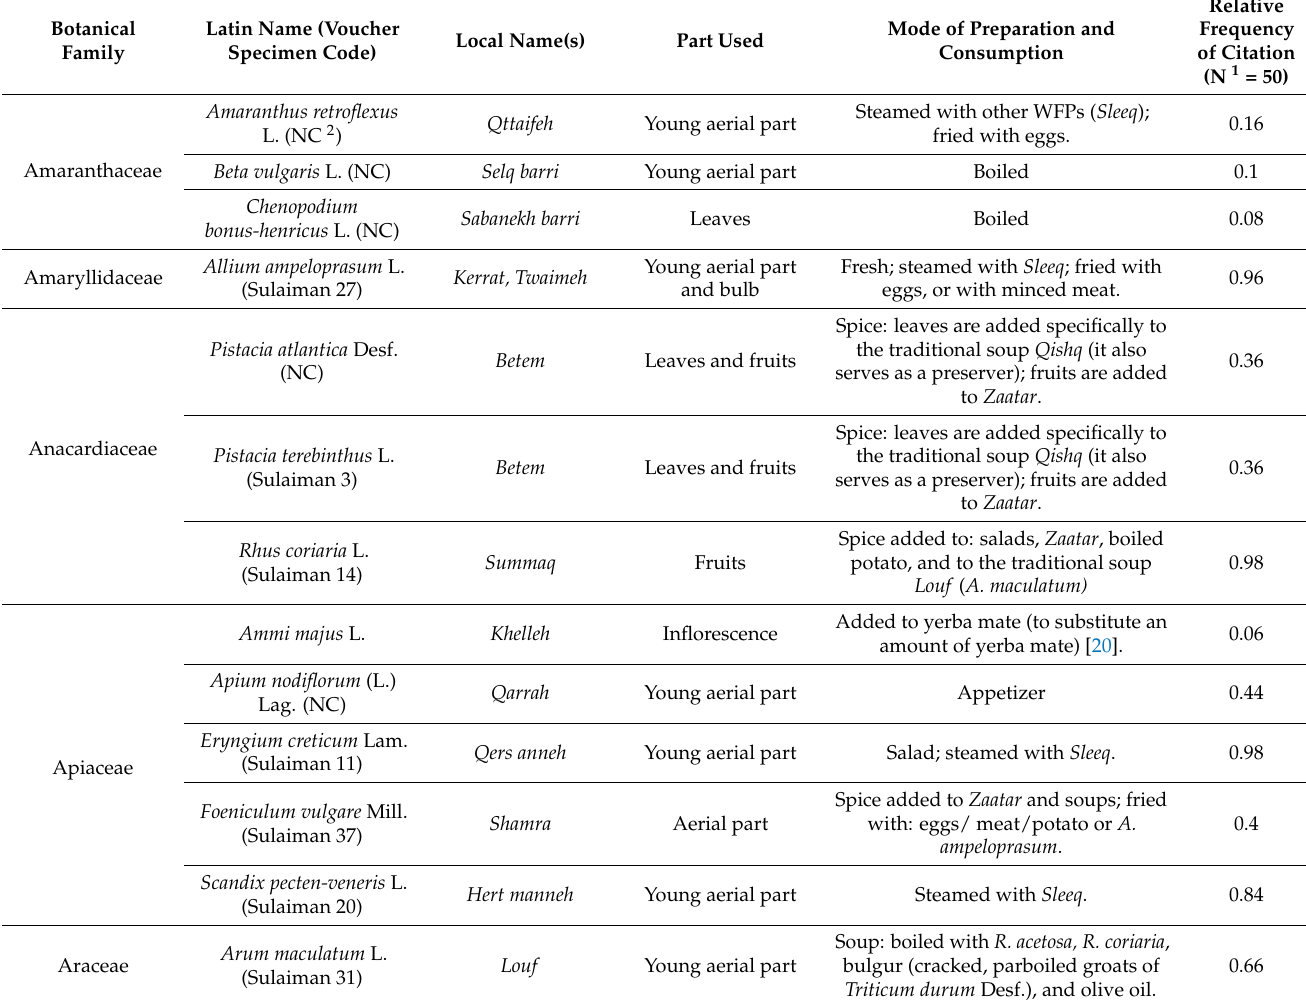
Table 1. Wild plant species used in food and beverage preparation in the study